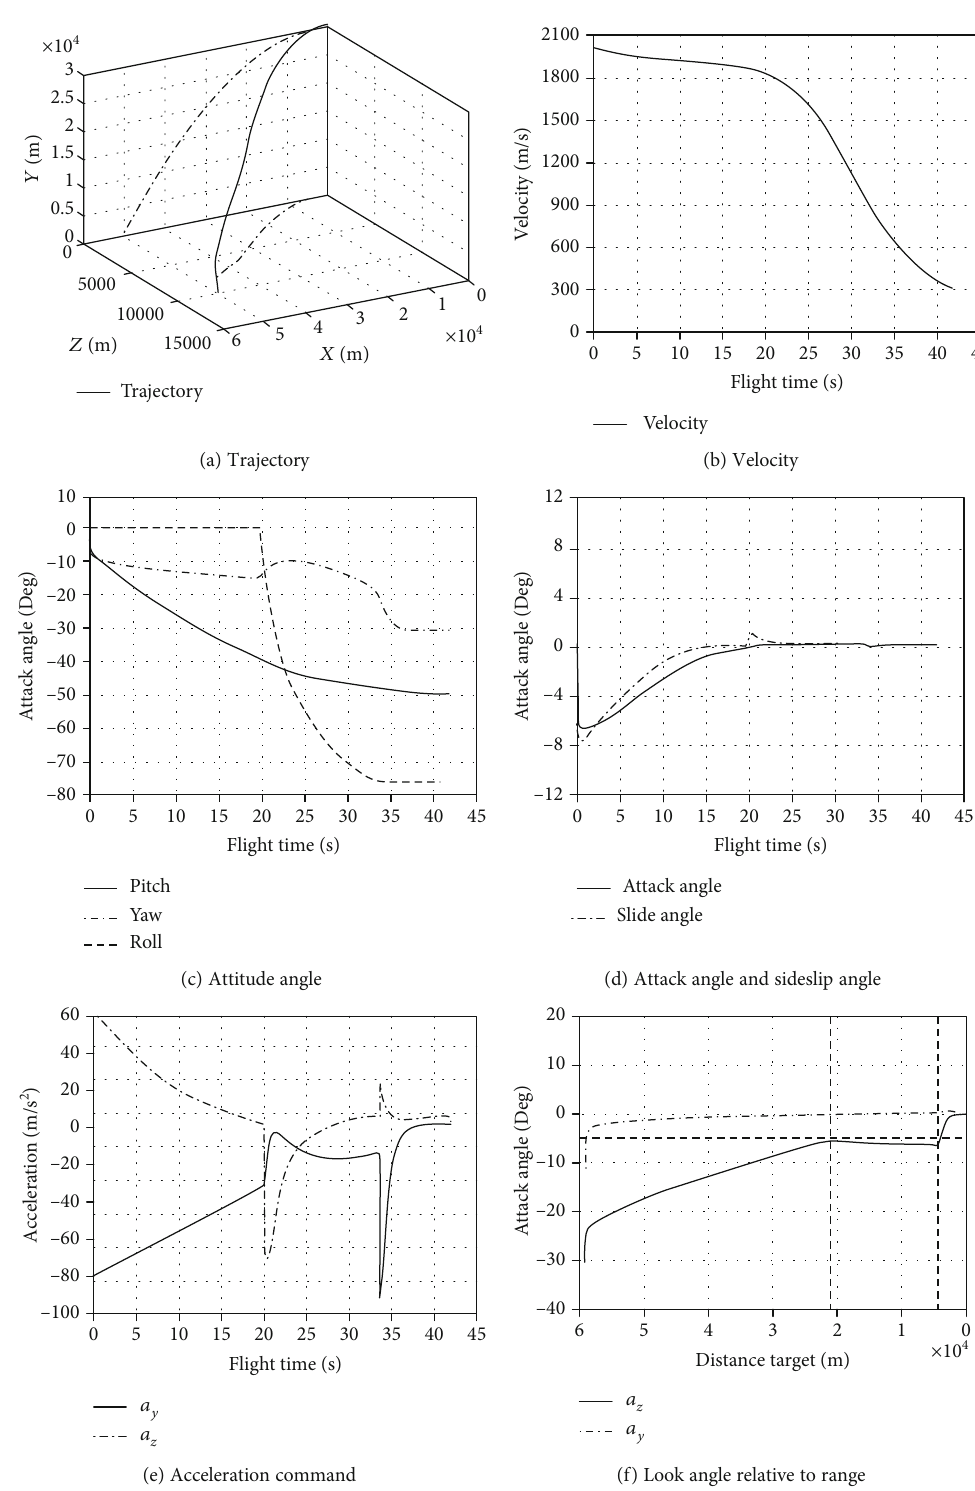
Figure 8: Simulation results adopting guidance